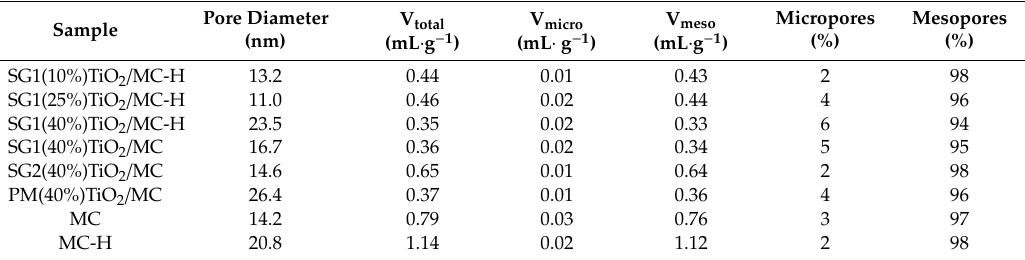
Table 4. Textural properties of the di ff erent catalysts used in the present